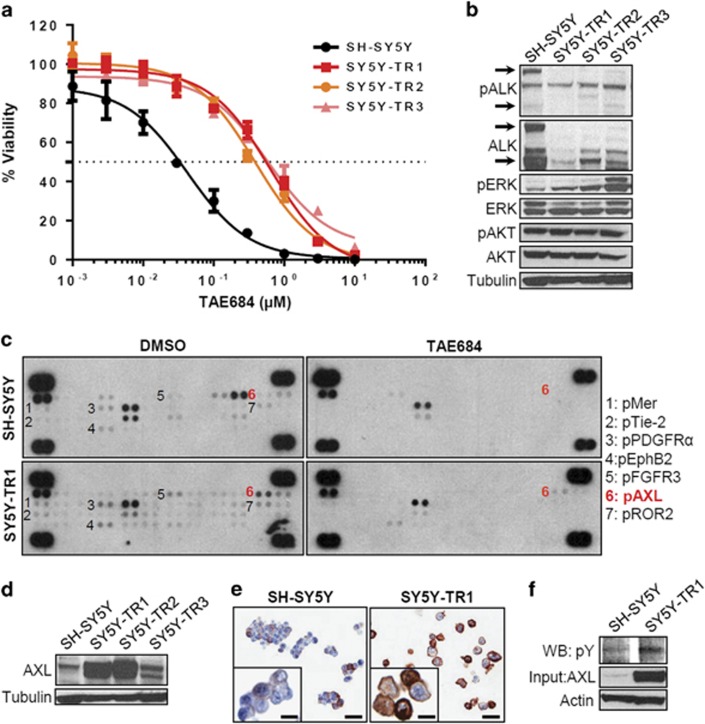
Development of TAE684 resistance is associated with activation of AXL in ALK-mutated SH-SY5Y NB cells. (a) Dose–response curves for parental SH-SY5Y cells and three TAE684-resistant clones (SY5Y-TR1 to TR3) treated with increasing concentrations of TAE684 for 72 h (half-maximal inhibitory concentration (IC50)=SH-SY5Y, 31 nM; SY5Y-TR1, 521 nM; SY5Y-TR2, 374 nM; SY5Y-TR3, 581 nM). (b) Western blot analysis of total and pALK and indicated downstream signaling molecules in TAE684-sensitive and -resistant SH-SY5Y cells. Arrows indicate ALK products of 220 and 140 kDa. (c) Phospho-proteomic analysis of RTKs in SH-SY5Y and SY5Y-TR1 cells exposed to either dimethyl sulfoxide (DMSO) or TAE684 (1 μM) for 6 h. Each RTK is shown in duplicate, and the pairs in each corner of the array are positive controls. Significantly regulated RTKs are numbered. (d) Western blot analysis of total AXL expression in parental SH-SY5Y and the three SY5Y-TR clones. (e) Immunocytochemical analysis of AXL expression in SH-SY5Y and SY5Y-TR1 cells (scale bars, 10 μm, insets, 5 μm). (f) Analysis of pAXL in SH-SY5Y and SY5Y-TR1 cells in which AXL was immunoprecipitated using an anti-AXL antibody, followed by western blotting with an anti-phosphotyrosine antibody. Tubulin or actin were used as loading controls in all western blots.